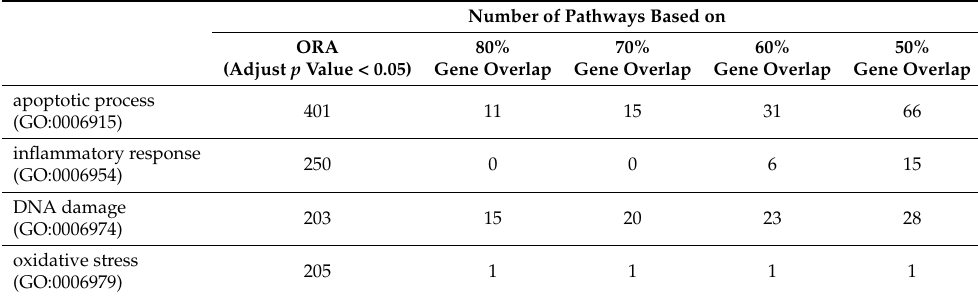
Table A1. Table containing the number of pathways related to the four GO-terms. Based on either an overrepresentation analysis ( p -value < 0.05), 80% gene overlap, 70% gene overlap, 60% gene overlap, or 50% gene overlap.